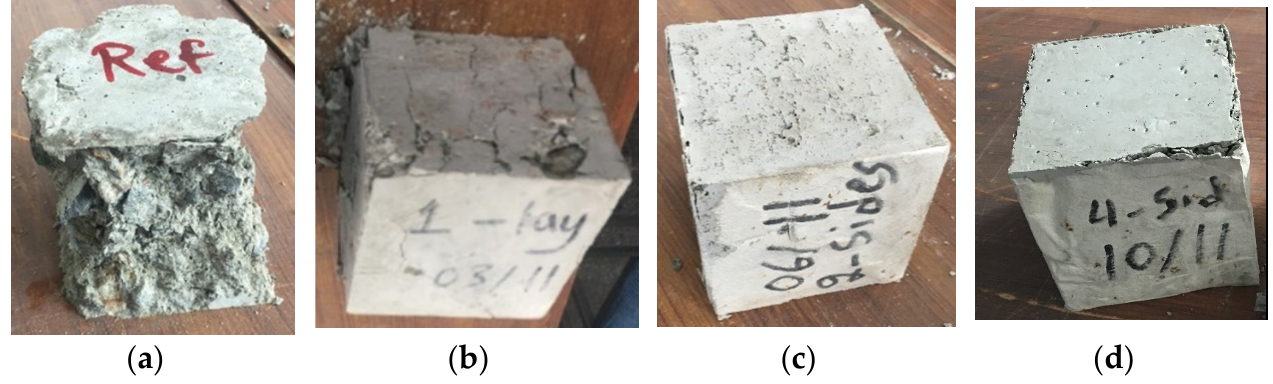
Figure 5. Cracking mechanism of cubes. ( a ) Reference, ( b ) 1 ‐ layer, ( c ) 2 ‐ sides, and ( d ) 4 ‐ sides .